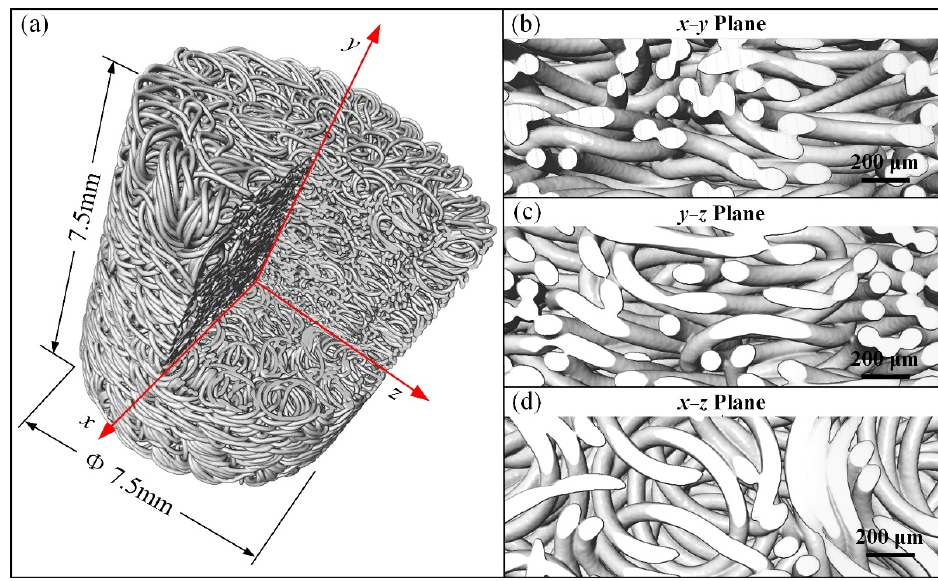
Figure 2. 3D X-ray CT microscopy images of MR cylinder: ( a ) reconstructed MR cylinder image with a corner cut out, ( b ) cross-section enlargement image in the x – y plane, ( c ) cross-section enlargement image in the y – z plane, ( d ) cross-section enlargement image in x – z plane.